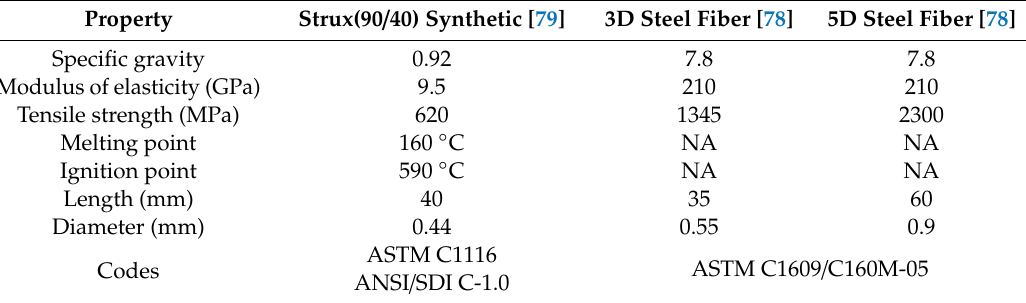
Table 4. Summary of fibers properties.